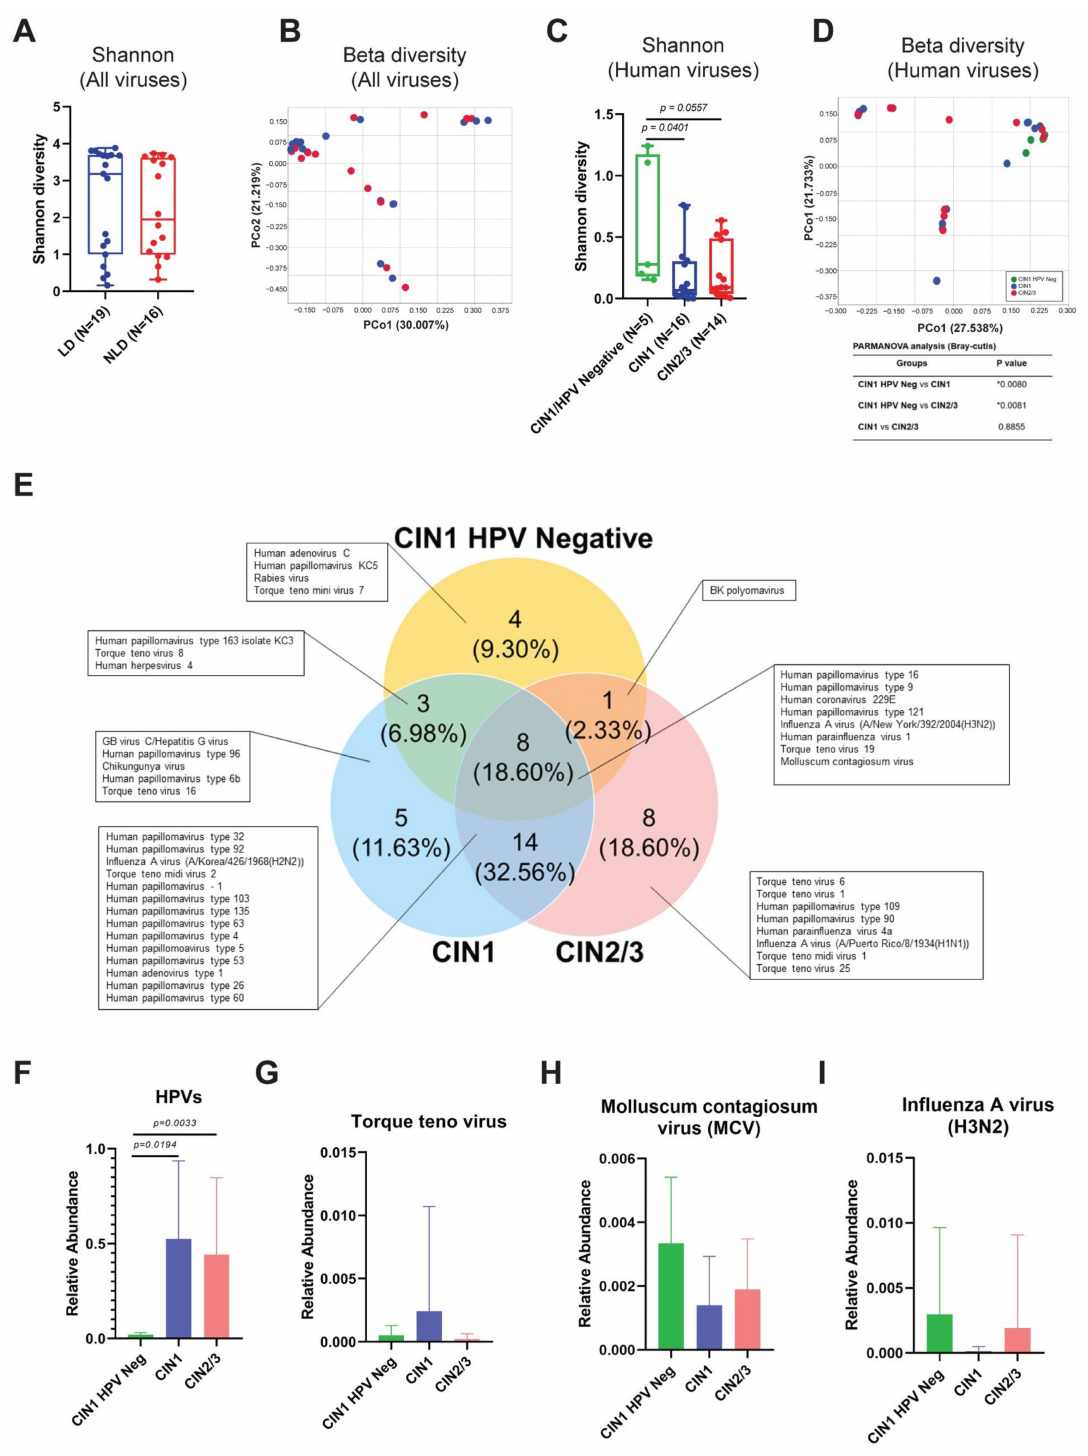
Figure 5. The composition of the viral community in cervical samples. ( A , B ) The viral diversity between LD (blue) and NLD (red) groups. ( C , D ) Viral diversity of Human viruses among different histological groups: Shannon diversity (alpha diversity) ( A , C ) and beta diversity ( B , D ). Asterisk indicates statistically significant difference by PERMANOVA analysis (Bray-Curtis). ( E ) Venn diagram represents the unique and shared viral OTU (species) among histological groups. ( F – I ) Relative abundance of each selected viral specie in all groups. Mann–Whitney U-test for non-parametric data was used for comparisons between the abundance of each group. Error bars represent the standard error of the mean